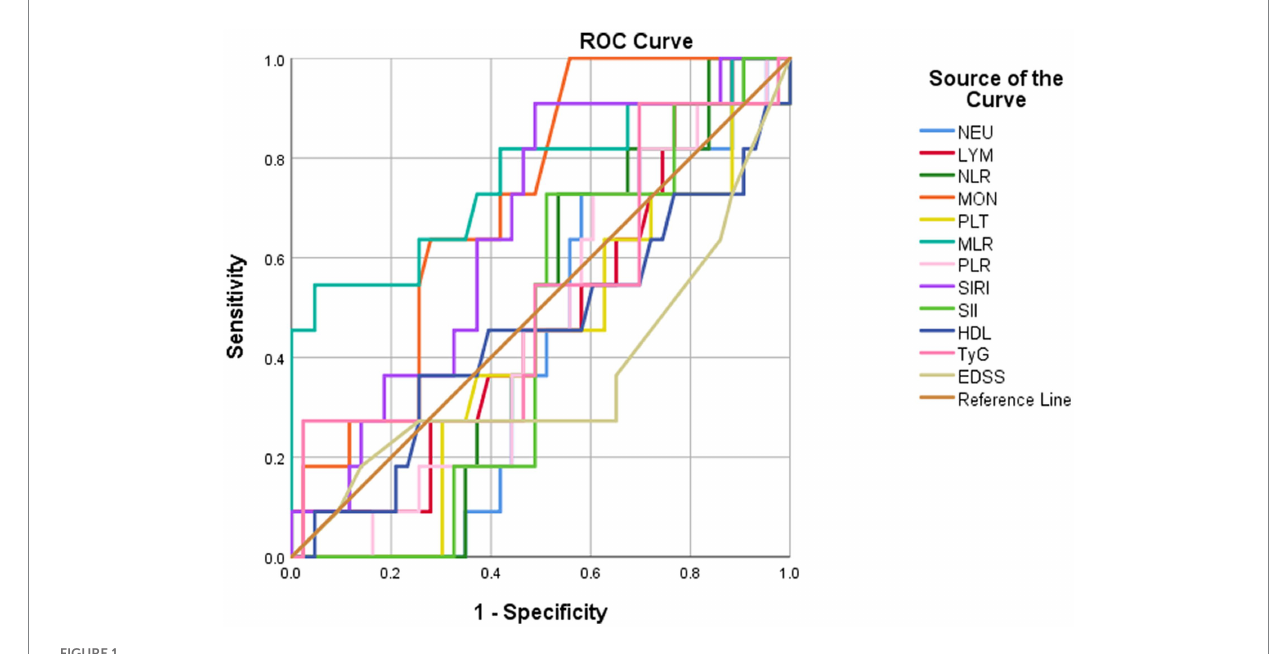
FIGURE 1 ROC curve analysis for predicting recurrence.